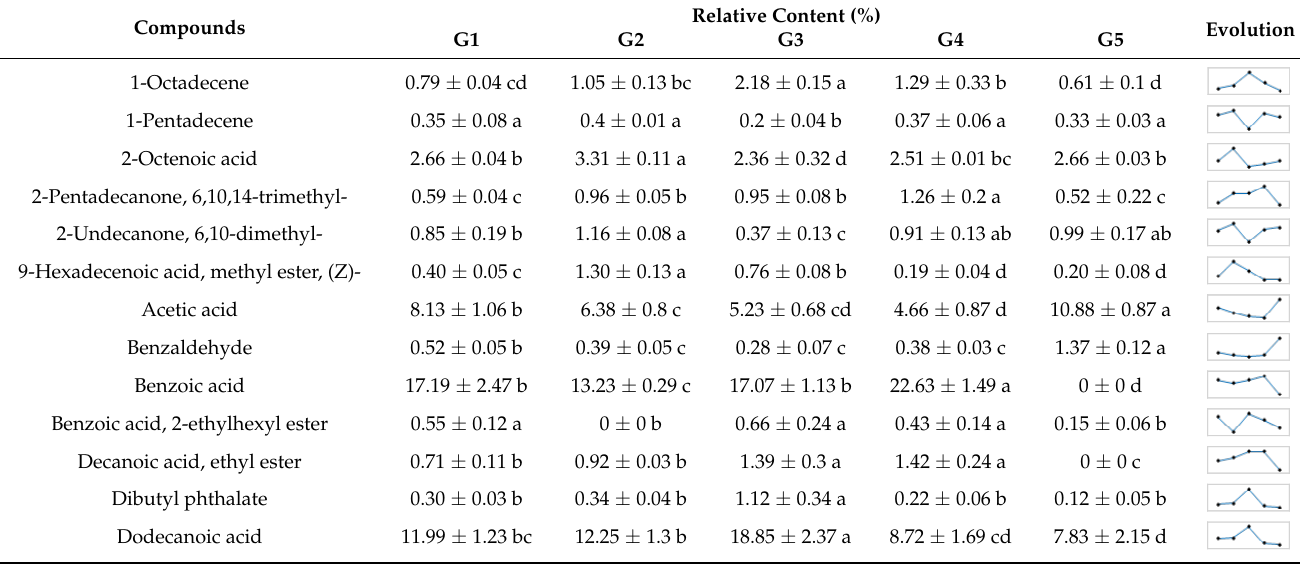
Table 4. The analysis of volatile aroma compounds of dried jujube.